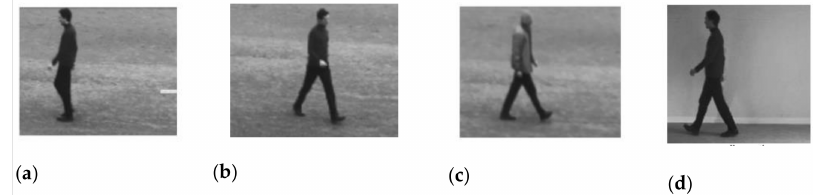
Figure 5. Example of input videos of a person in four scenarios. ( a ) Outdoors (d1), ( b ) Outdoors with scale variation (d2), ( c ) Outdoors with different clothes (d3), ( d ) Indoors